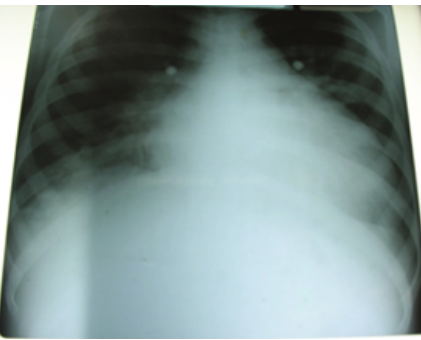
Figure 1: Chest X-ray showing the massive cardiomegaly.